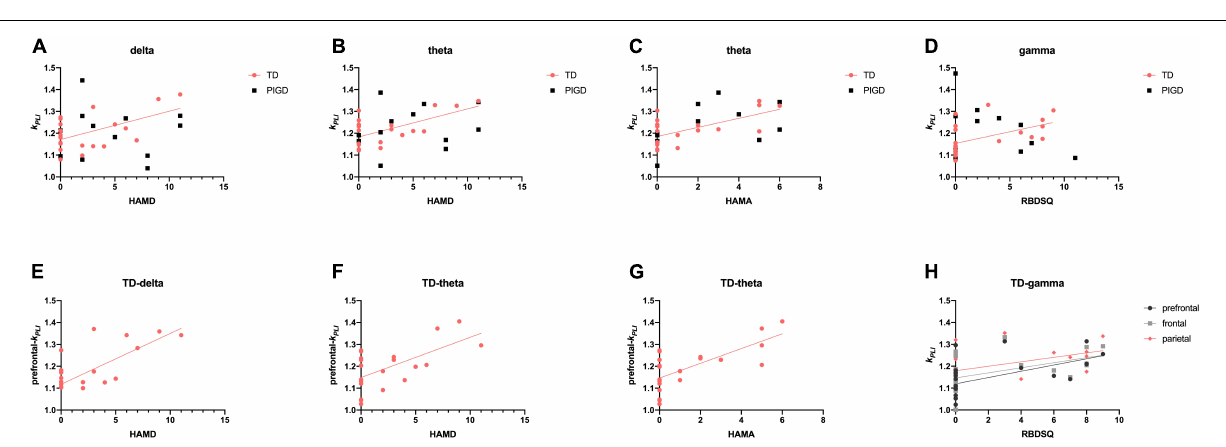
( r = − 0.490, p < 0.05, Table 4 ) and with RR in the gamma band in the PIGD group ( r = − 0.727, p < 0.01, Table 5 ). In terms of plasma t-tau, there was a significant positive correlation with k PLI in the delta ( r = 0.571, p < 0.01), theta ( r = 0.697, p < 0.001), beta ( r = 0.483, p < 0.05), and gamma ( r = 0.442, p < 0.05)